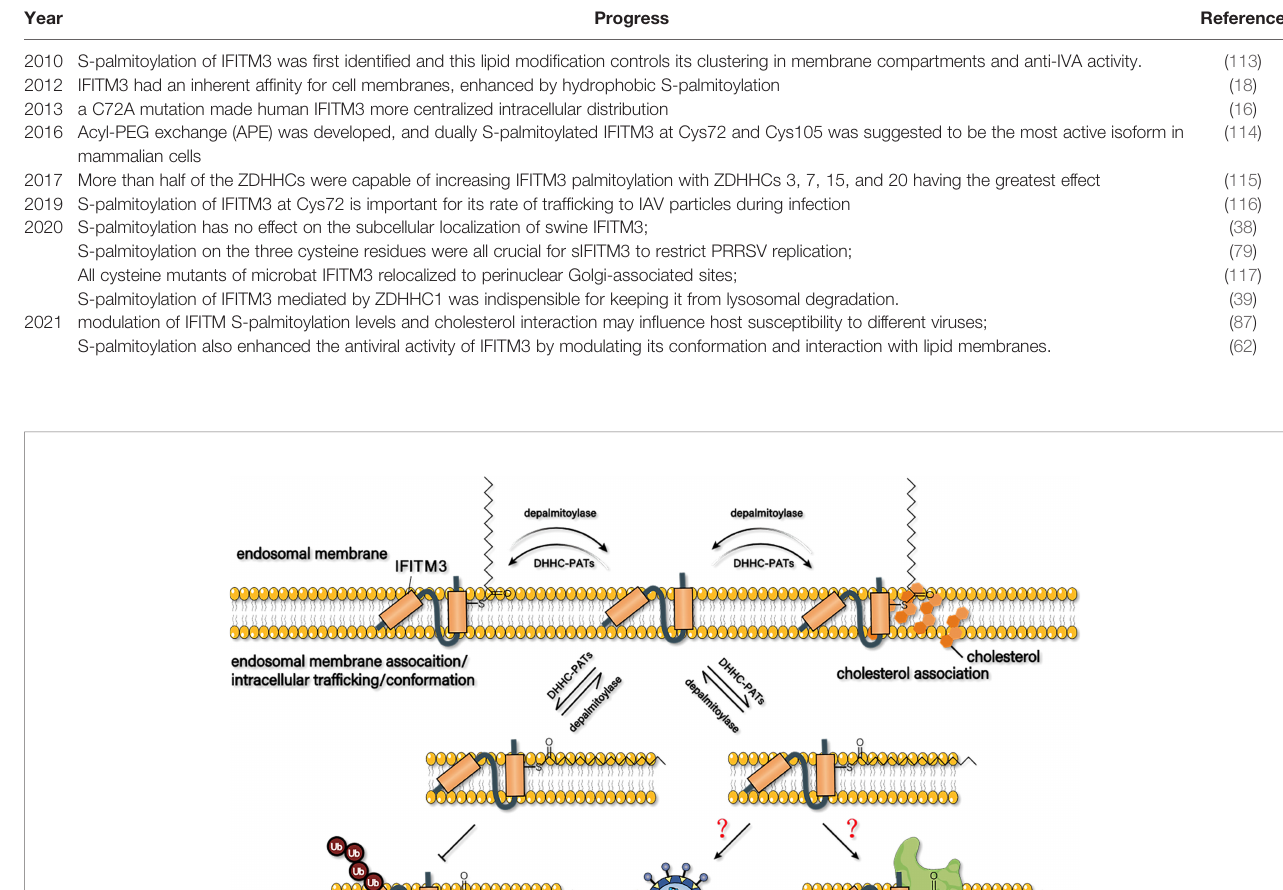
TABLE 1 | Research progresses of IFITM3 S-palmitoylation.